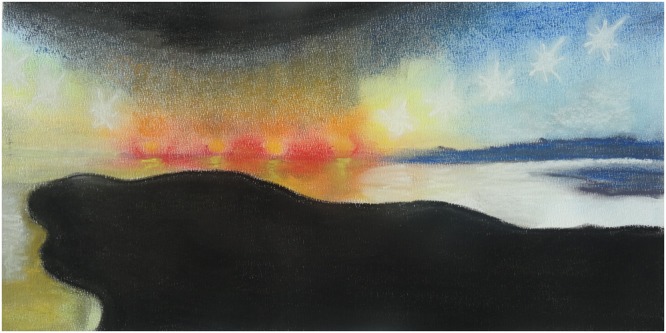
Emotional landscape.